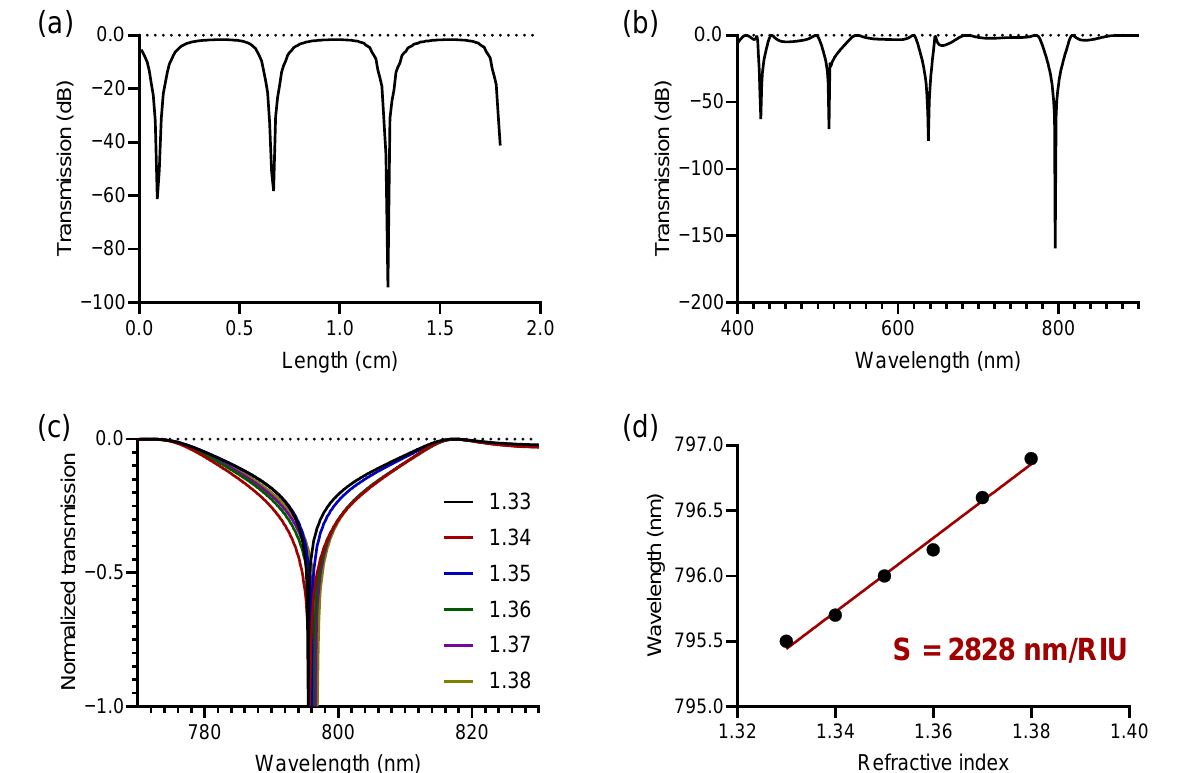
Figure 7. Propagation analysis in the proposed MZI biosensor, based on double monolayer of graphene capacitor. ( a ) Trans- mission response where the phase shift is evaluated as a function of the variation of the length of the sensing area ( L sens ) at 800 nm wavelength and 1.33 refractive index in the cladding ( b ) Transmission response where the phase shift is evaluated as a function of the wavelength variation between 400 nm and 900 nm, for 1.24 cm length in the sensing area. ( c ) Close-view of the redshifted normalized transmission in the region where the maximum phase shift occurs, for refractive indices between 1.33 and 1.38 with a step of 0.01 RIU. ( d ) Sensitivity obtained through a linear regression calculated on the simulations carried out in ( c